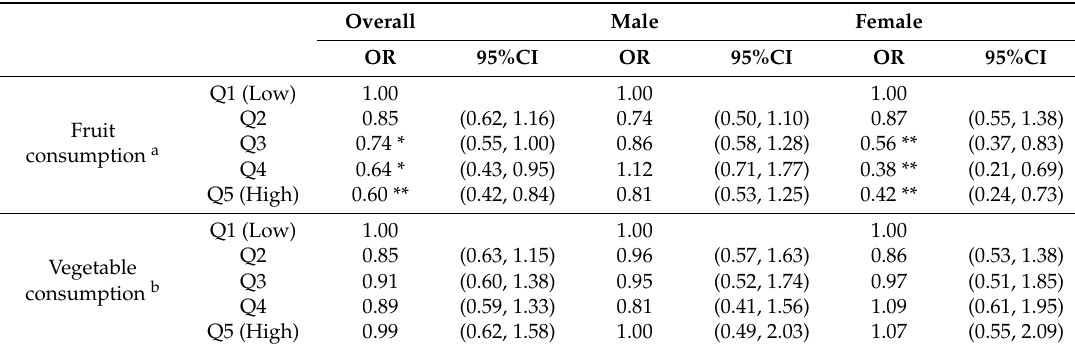
Table 2. Association of fruit and vegetable consumption (quintiles) with sarcopenia estimated by multivariable logistic